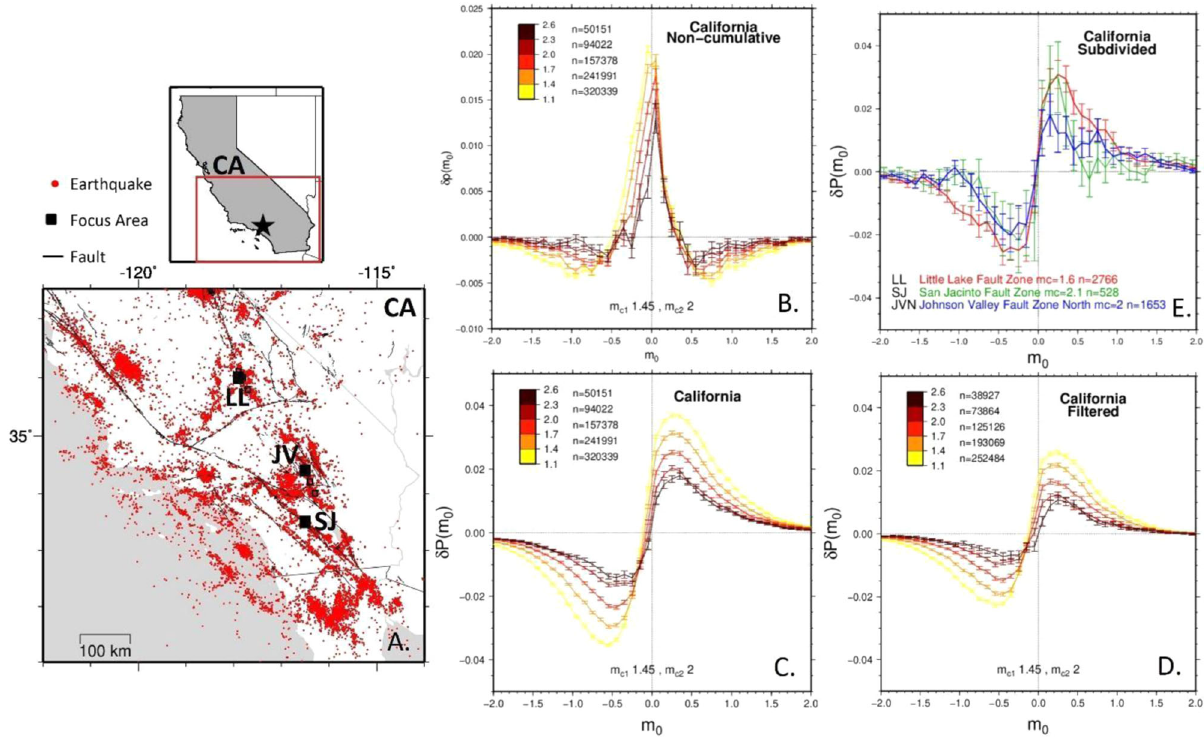
(cid:1) (cid:3) δ P m Fig. 1 | Study area and magnitude clustering plots.A Map ofsouthernCalifornia ,forthesouthernCaliforniacatalogbeforeapplying fi lters. D Sameas C but 0 after applying fi lters to address potential issues from catalog study area. B Non-cumulative distribution of difference in probability between the (cid:1) (cid:3) , as a function of magnitude observed catalog and a randomized version, δ P m 0 difference ( m 0 ), for the southern California catalog. m c = magnitude of com- pleteness, n = numberof events. Error bars correspond to the 1 standarddeviation con fi dence interval. C Cumulative distribution of the difference in probability,